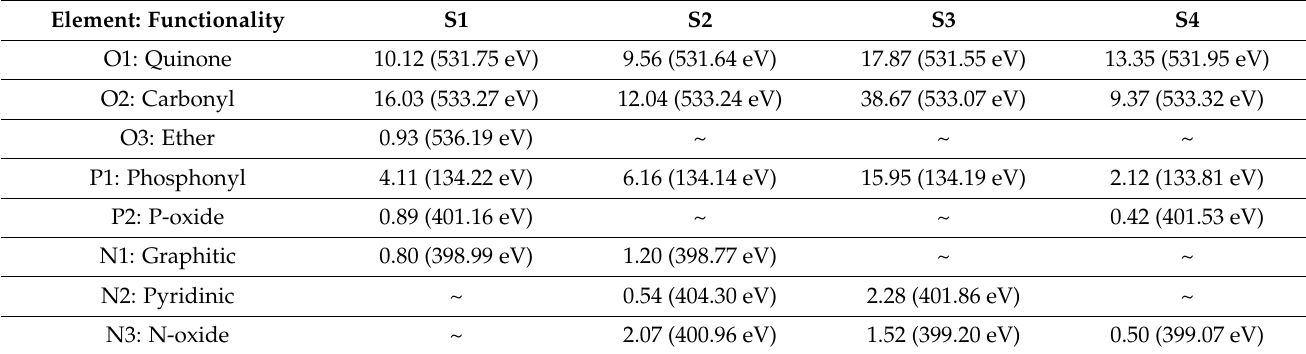
Table 3. Detailed narrow scan XPS analysis of functionalities on S1–S4 surfaces.